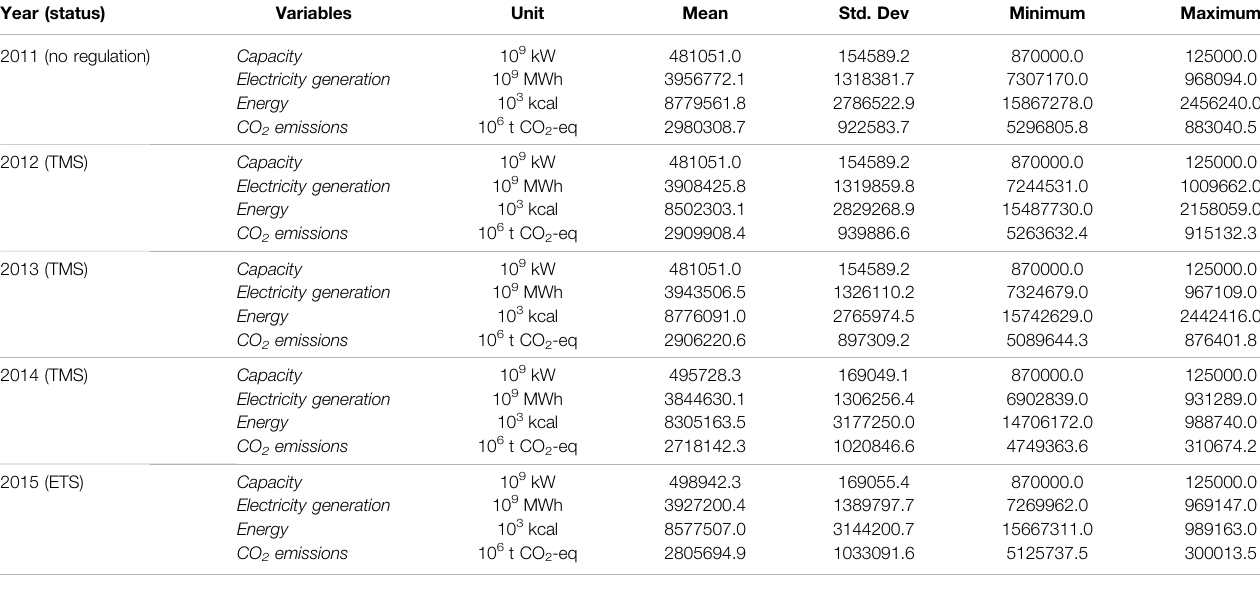
TABLE 1 | Descriptive statistics of data for Korean coal- fi red power plants from 2011 to 2015.